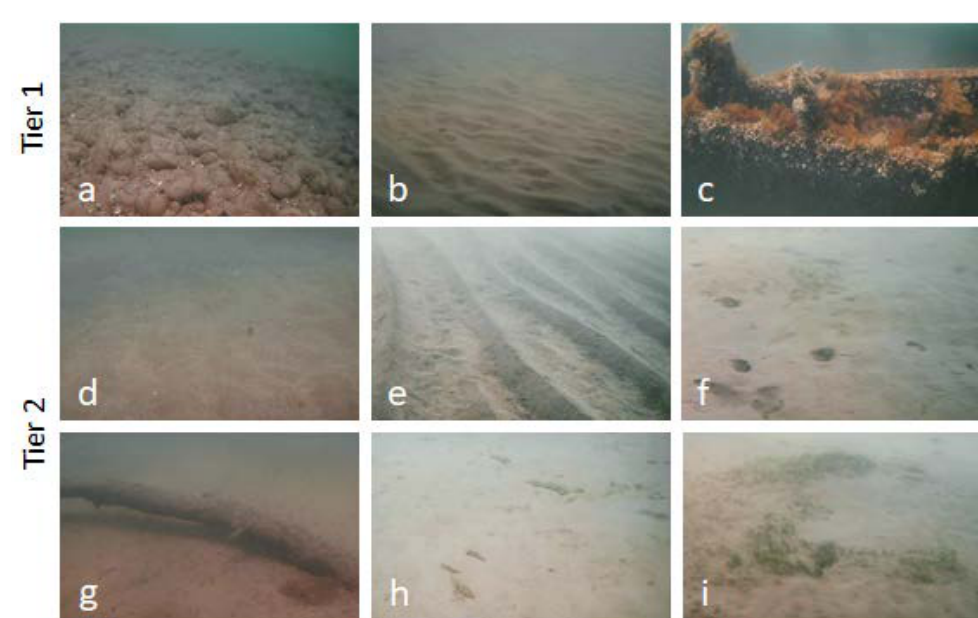
Figure 6. Tiered CMECS class short names and class values (class tier index numbers).